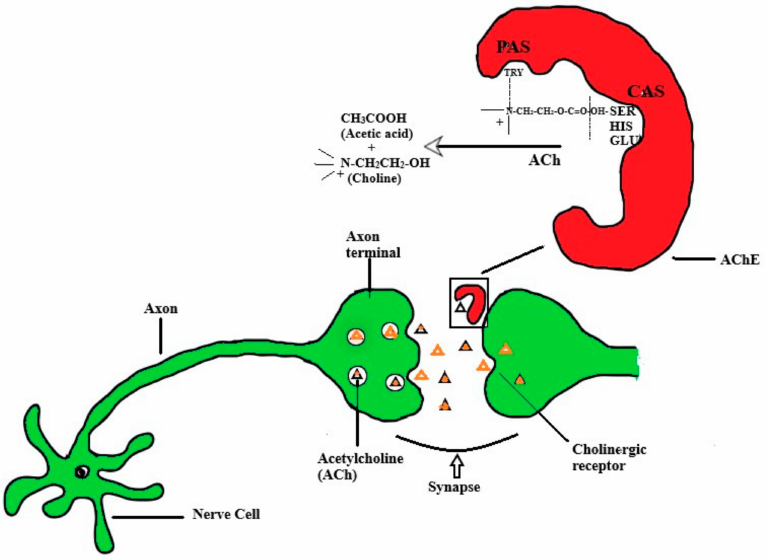
Figure 1. Acetylcholine (Ach) transmission through synapse (cholinergic transmission) and action of acetylcholinesterase (AChE) on acetylcholine. ACh: acetylcholine; AChE: acetylcholinesterase; PAS: peripheral anionic site; CAS:catalytic active site; TRY: tryptophan; SER: serine; HIS: histidine; GLU: